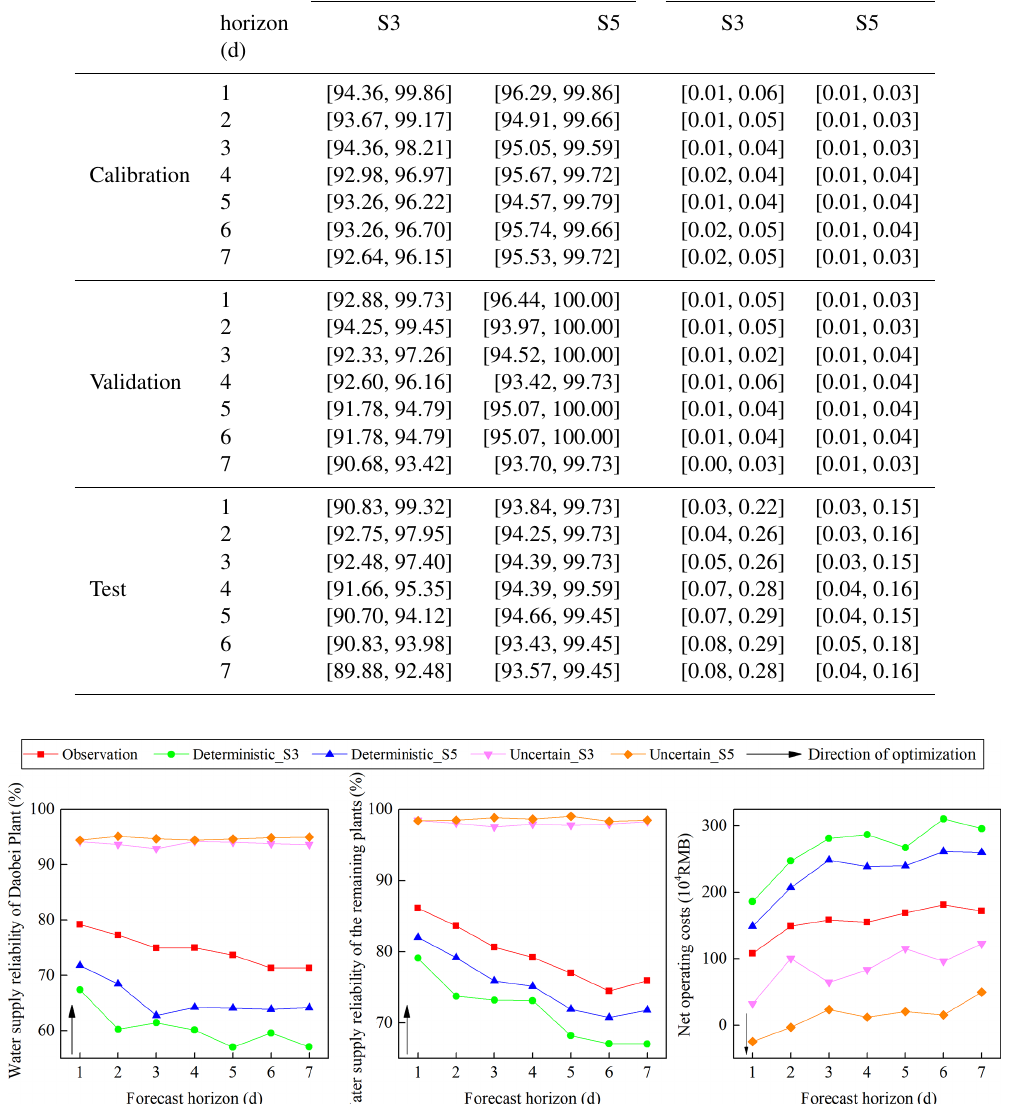
model provided the best prediction, but the BMA did display better forecast skills in comparison to the individual